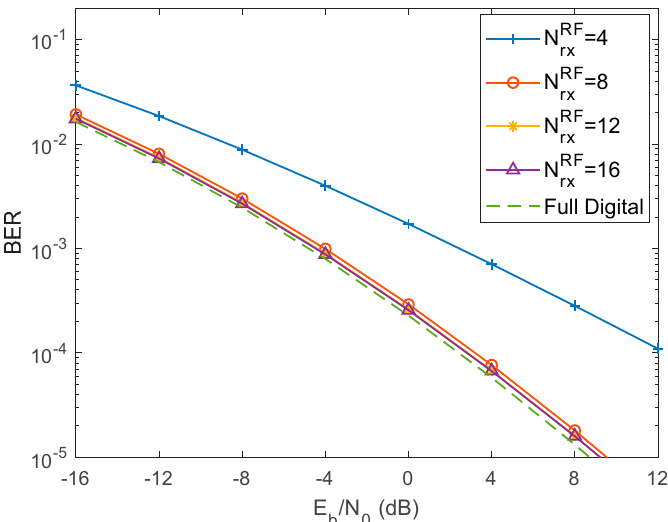
that we obtained before.